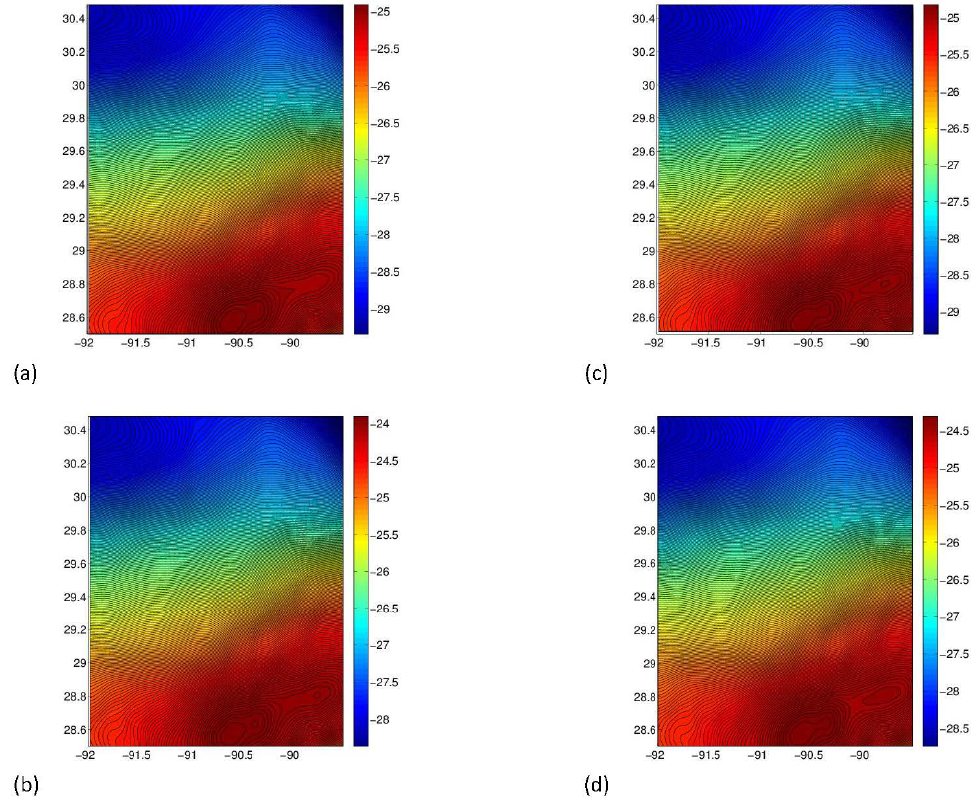
Figure 5: GMS (a) and QGMS (b) geoid vs. EGM08 (c) and USGG12 (d) geoid for the Louisiana test area in 2 cm contours.